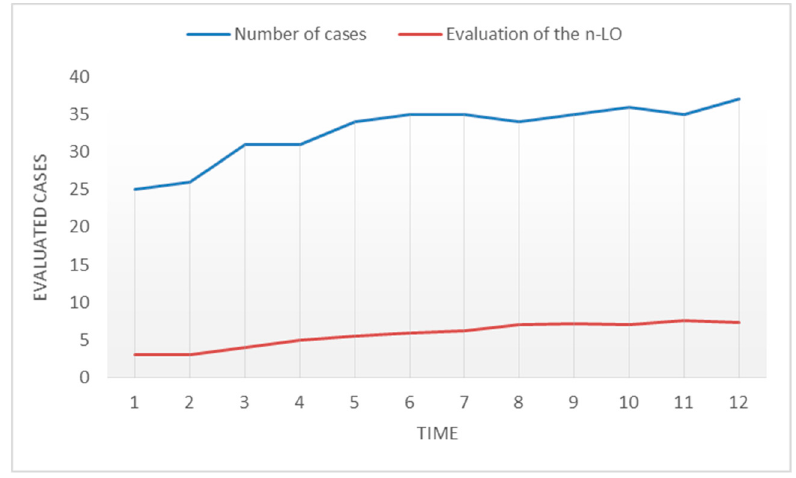
Figure 14. User evaluation of the case-based reasoning (CBR) recommendations.